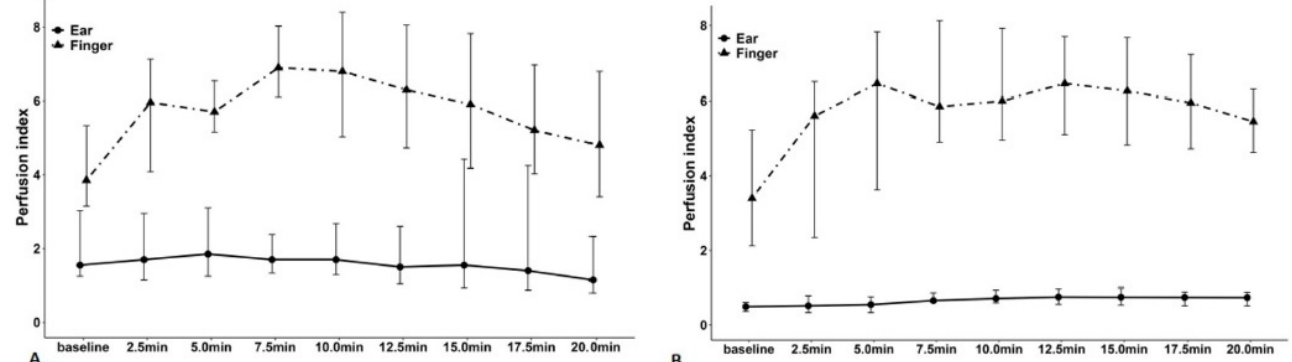
Figure 1. The variability in the ear and finger perfusion indices during the post-induction period in the non-hypotension and hypotension groups: ( A ) Non-hypotension group. ( B ) Hypotension group.